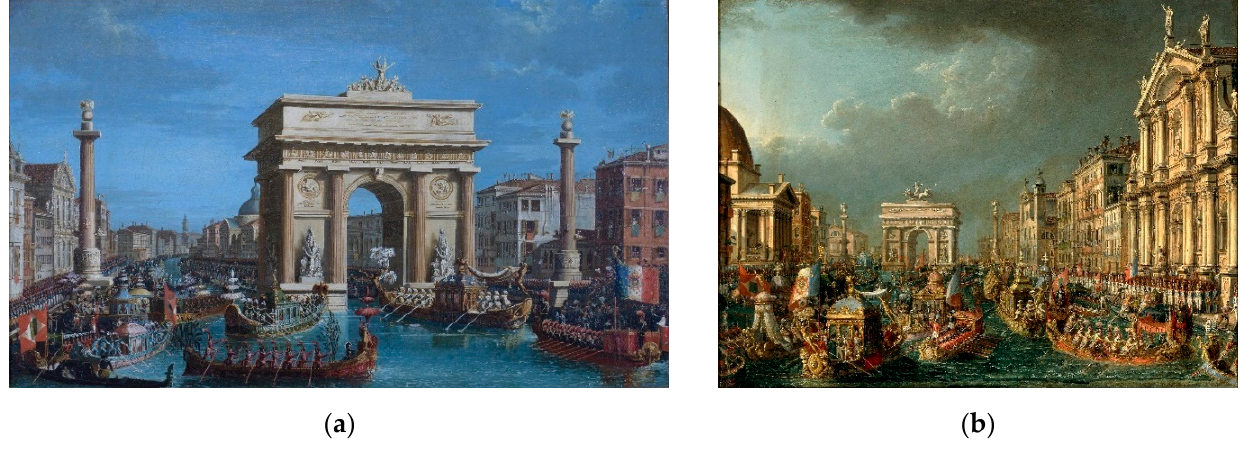
Figure 10. ( a ) G. Borsato, The Entrance of Napoleon I into Venice on 29 November 1807, 1809, Museo Mario Praz, Roma; ( b ) G. Borsato, The Entrance of Napoleon I into Venice on 29 November 1807, 1847, Veneranda biblioteca Ambrosiana, Milano.